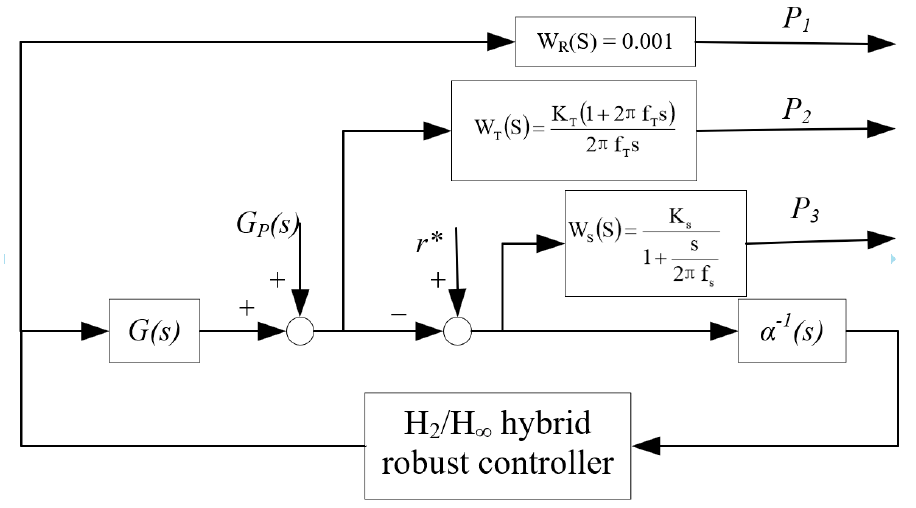
Figure 6. AFS vehicle stability control system structure.